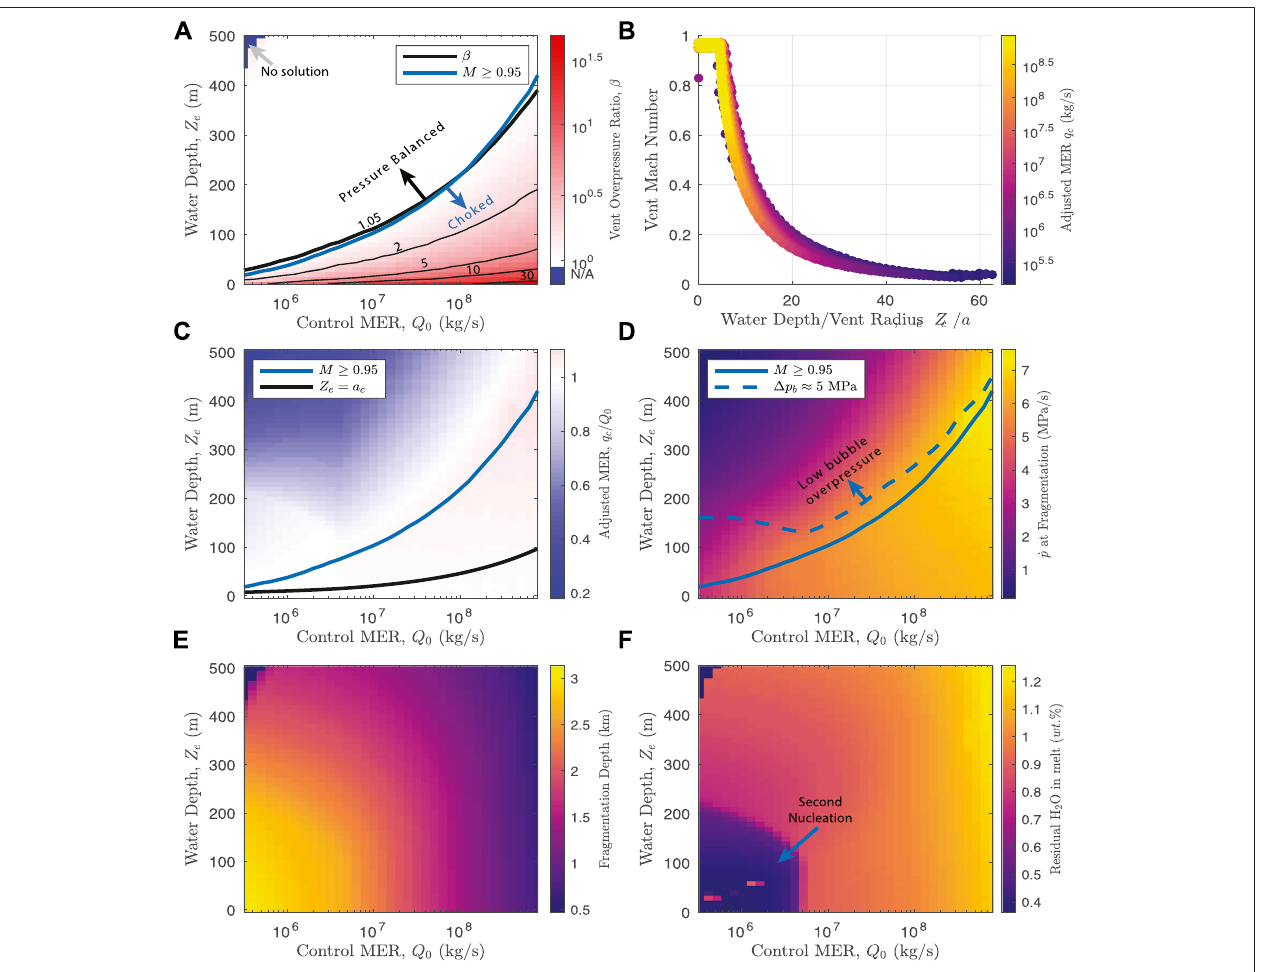
FIGURE5 | Conduit model outputasafunction ofcontrol MER, Q 0 ,and external water depth, Z e . (A) Vent overpressure β . The blue linein panels (A,C,D) denotes the tolerance threshold for Mach number ( M = 0.95), and the red line is the (approximately coincident) vent overpressure threshold, β = 1.05. The vent is choked and overpressured for water depths less than this. The blue region in the top left (high Z e and low Q 0 are failed simulations - no viable conduit solutions were found in this region. (B) VentMach number. (C) Mass eruption rateadjustmentfor fi xed conduit radius,relativetothecontrolcase for Z e =0. (D) Maximum decompression rate recorded at fragmentation ( χ 0 = 0.75). The dashed blue line highlights the maximum water depth for which peak bubble overpressure is at least 5 MPa, which is an approximate lowbound for bubble wall rupture (Cas and Simmons, 2018). (E) Fragmentation depth. (F) Residualdissolved waterinpyroclasts atthe vent, highlightinga strong second nucleation event for low MER and water depths less than about 200